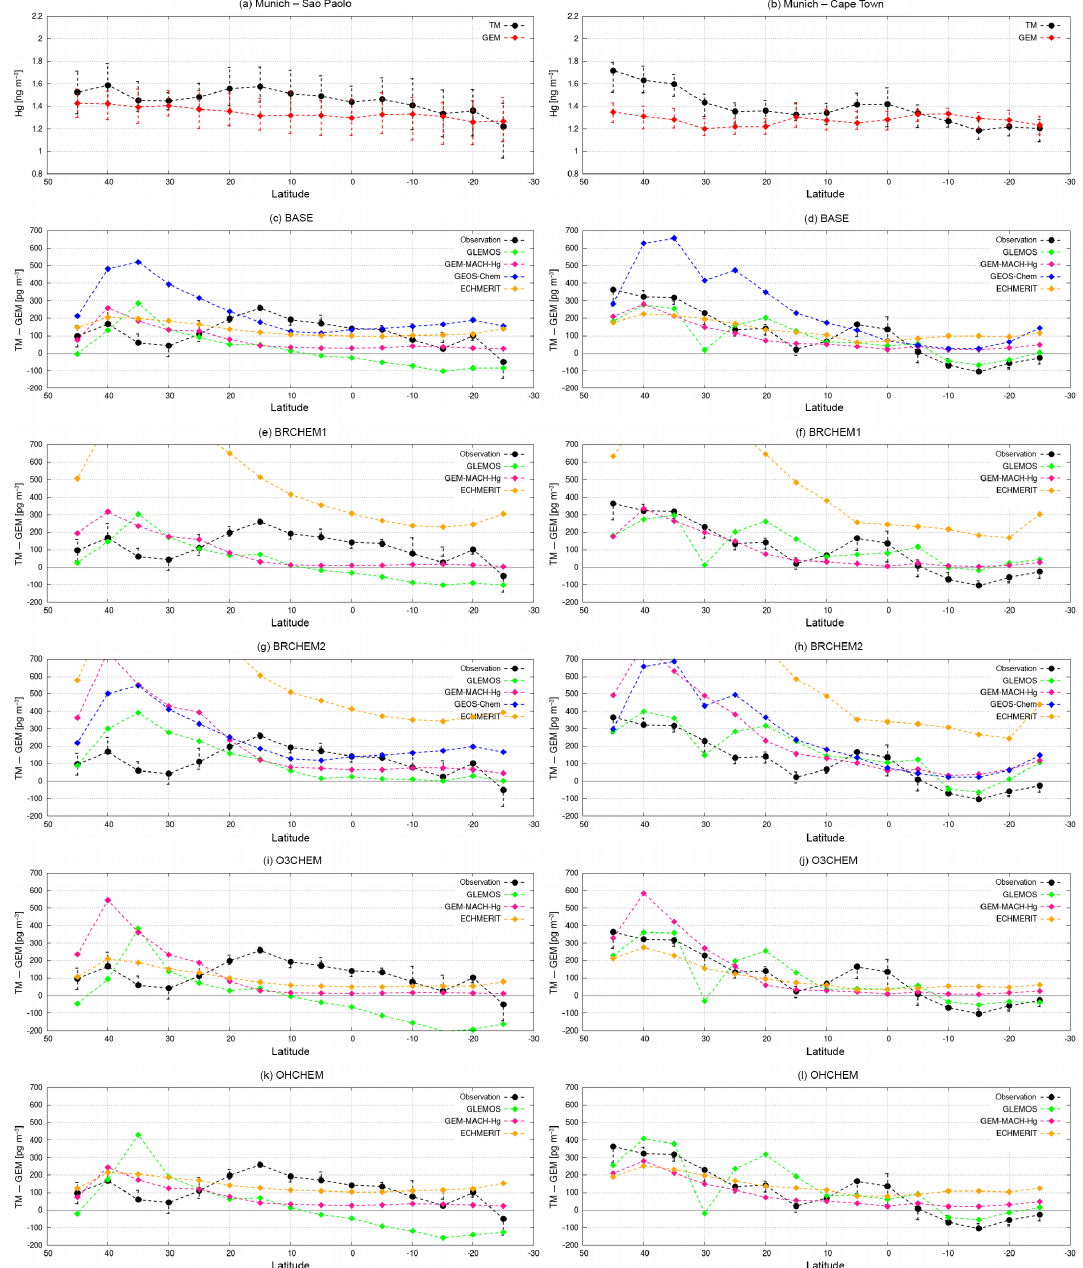
Figure 12. Average interhemispheric transects for 19 flights from Munich to Sao Paulo (left) and 8 flights from Munich to Cape Town (right). Error bars indicate the 66% quantile range of all observations for a given latitude. Average OM concentrations are calculated as TM–GEM where TM was measured on the outward and GEM on return flights; thus negative values for OM are possible (Slemr et al., 2014).